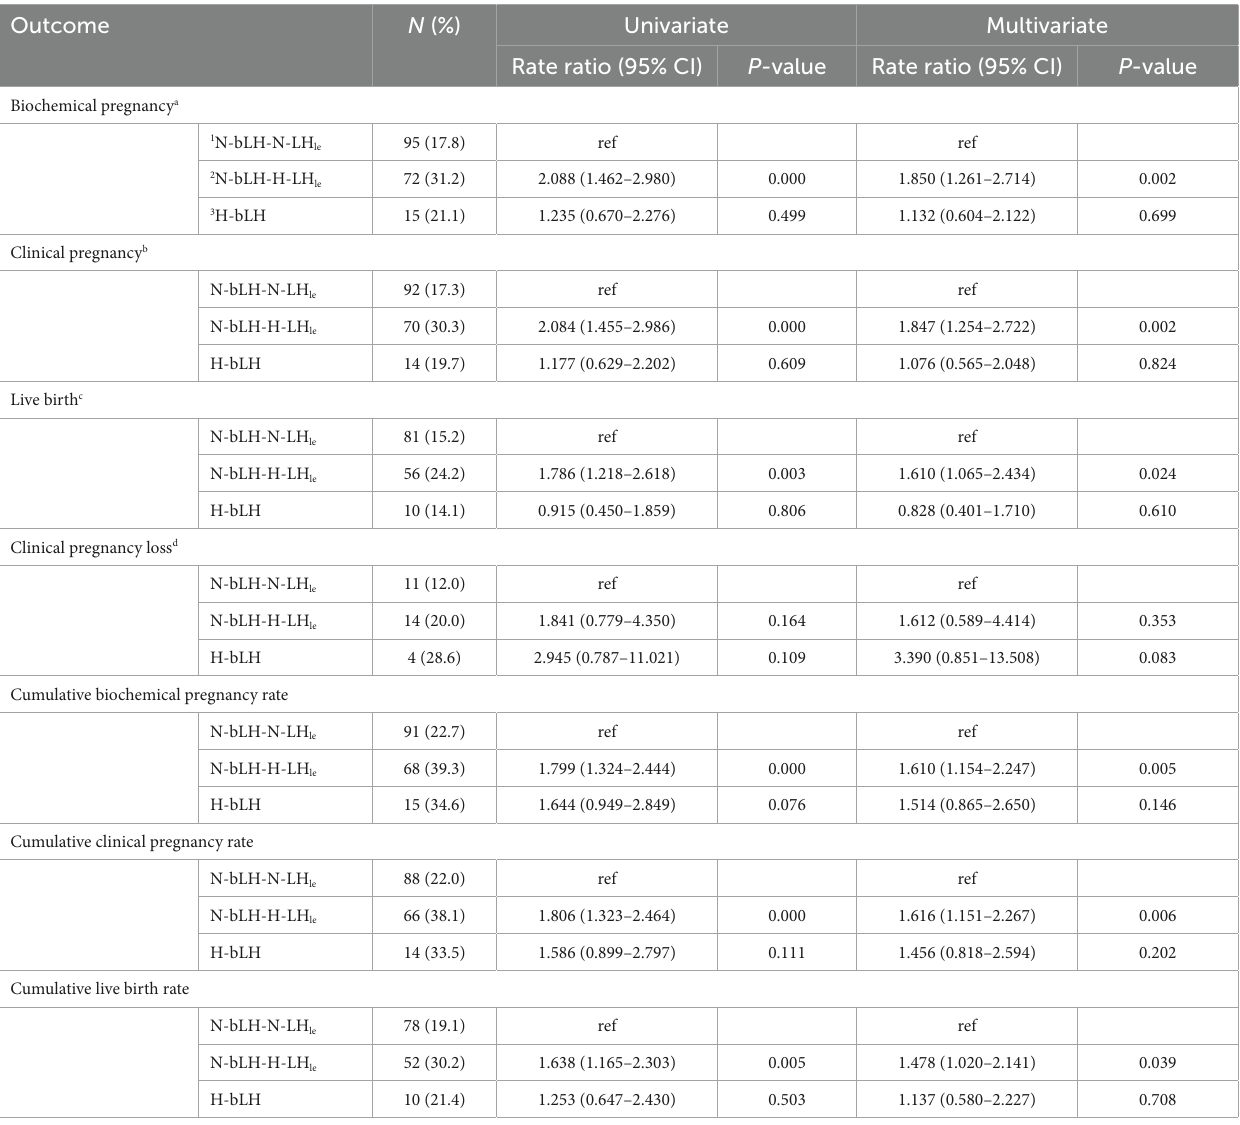
TABLE 2 Live birth, pregnancy, and pregnancy loss * .